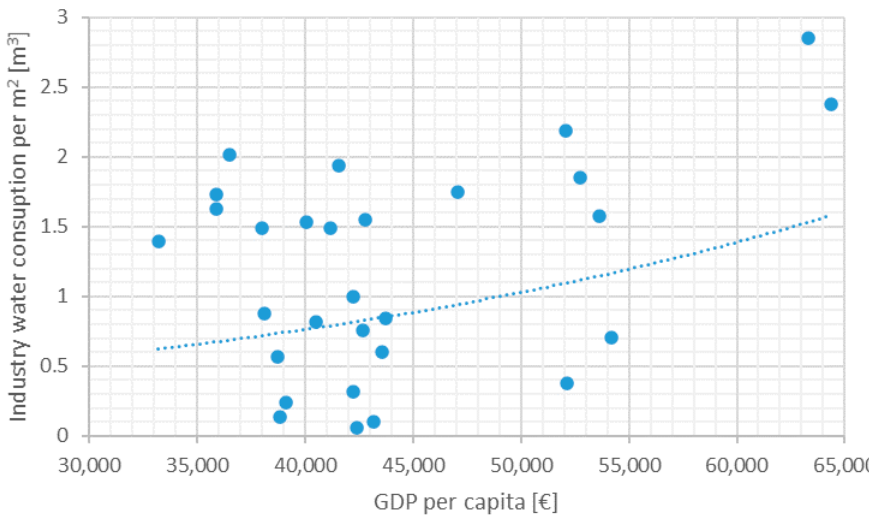
Figure 5. Water demand in industry per m 2 of ground area in log scale in relation to GDP per capita. The trend line is required by the regression analysis. Expansional correlation is 𝑦 = 0.2315 ∙ exp (3 (cid:2879)(cid:2873) ∙ 𝑥)